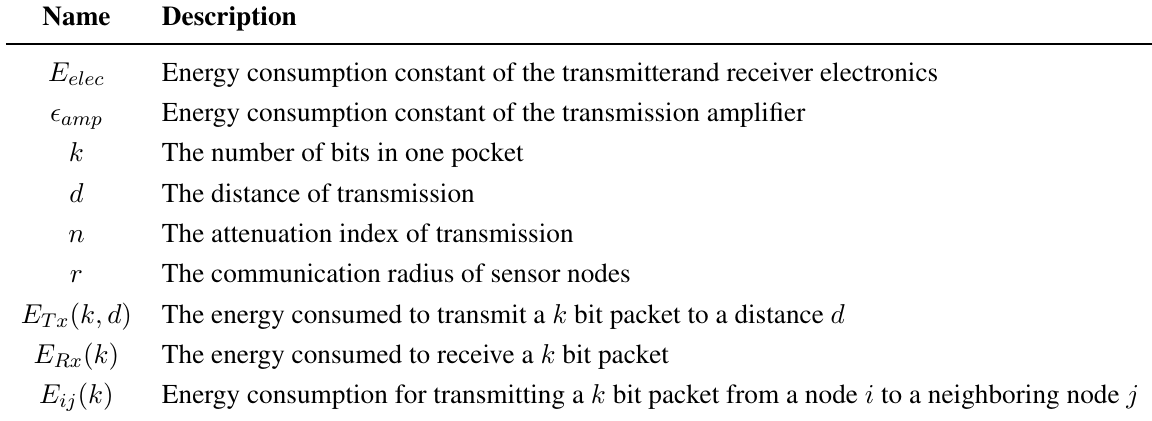
Table 1. Parameters in the energy model